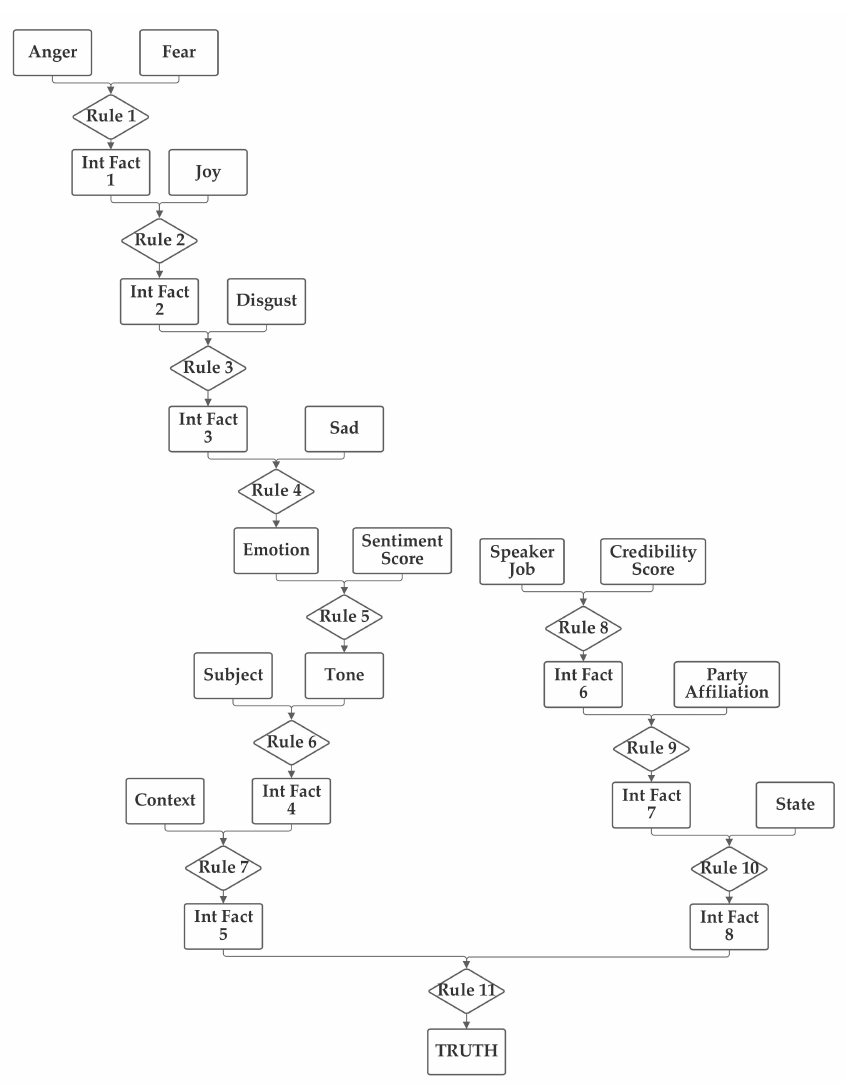
Figure 7. Depiction of Rule-Fact Network